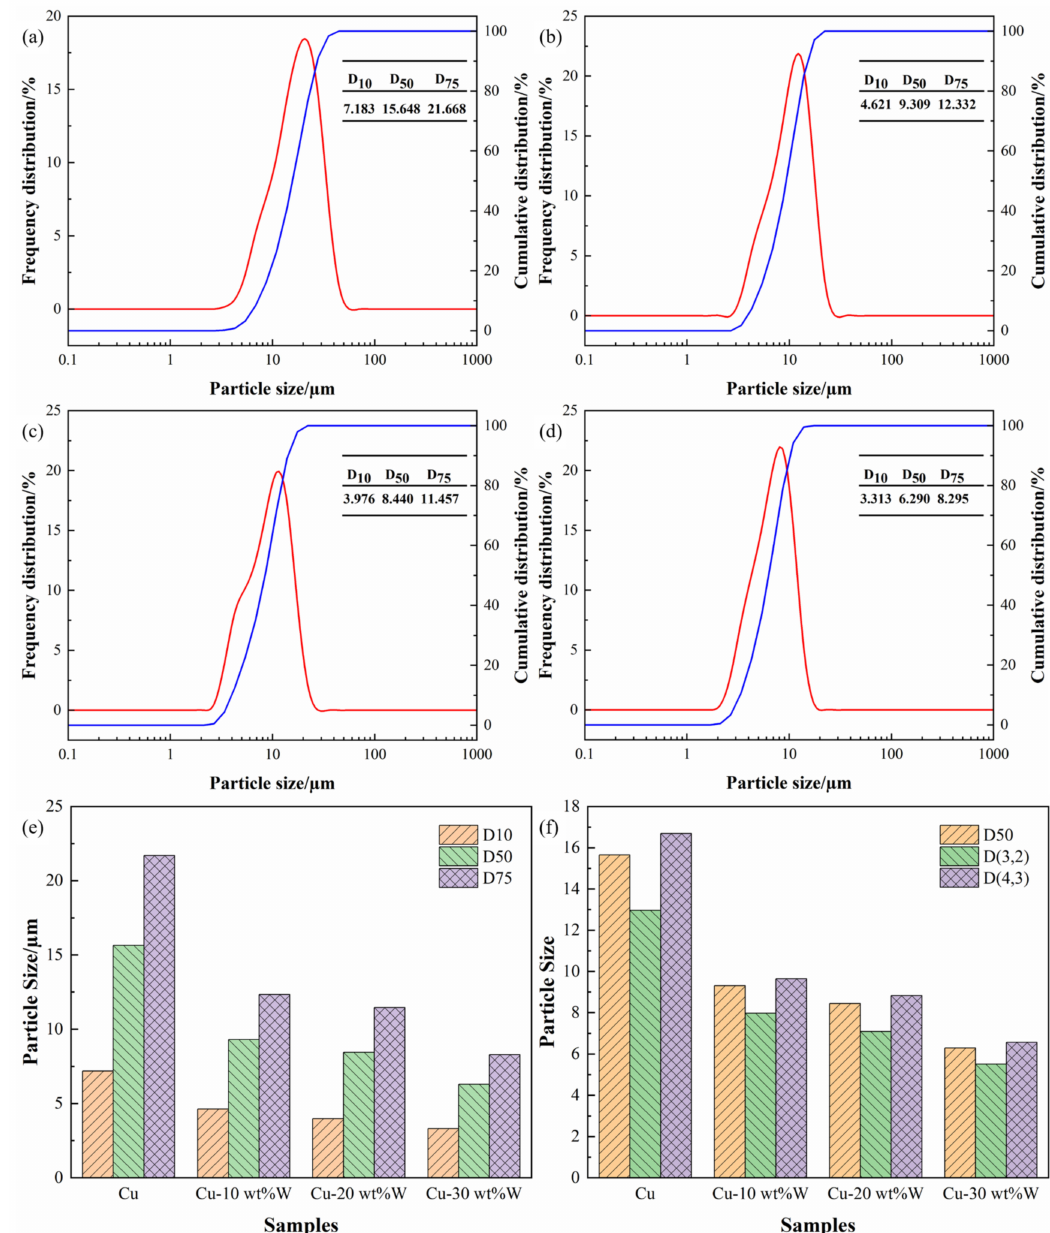
Figure 18. Particle size distribution: ( a ) Cu; ( b ) Cu-10 wt%W; ( c ) Cu-20 wt%W; ( d ) Cu-30 wt%W; ( e ) D10, D50, D75 values of the reduced powders ( f ) distribution histogram of the reduced